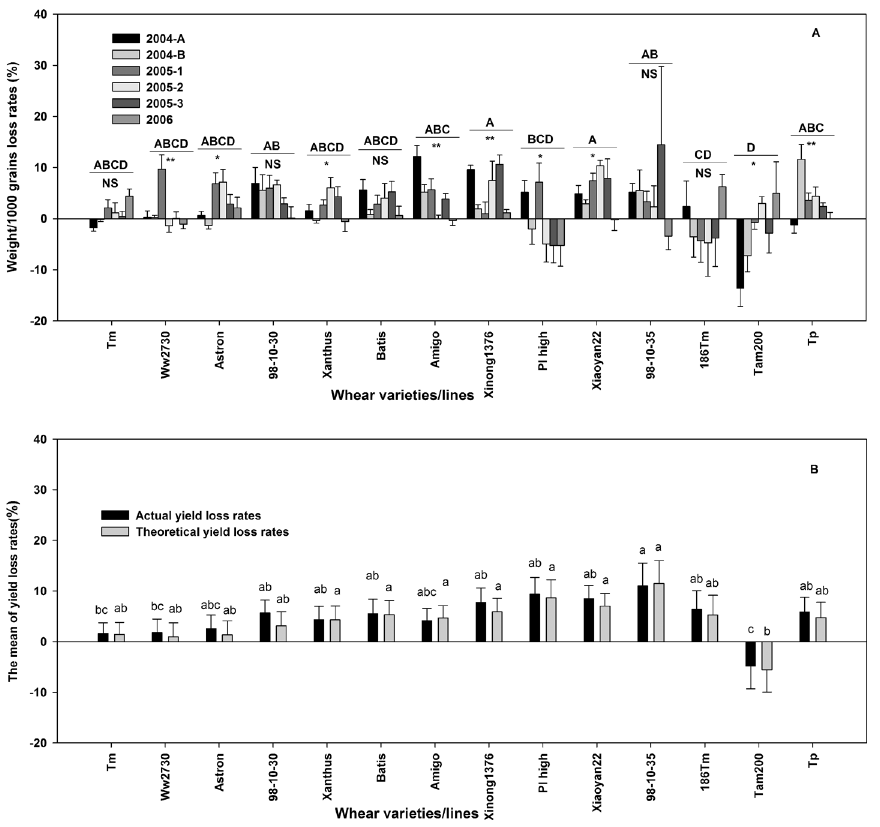
Fig 6. The loss rates of the 1000 grain weight (KW), for the 14 wheat varieties on 6 fields/sections over 3 years (A), and the loss rates average of theoretical yield (TY) and actual yield (AY) for the 14 wheat varieties based 6 fields/sections over 3 years. In part A, different capital letters above the horizontal lines indicate the significance of differences of the averages of the 6 fields/sections across the 14 wheat varieties/ lines. Strongly significant ( p < 0.01) values are marked as ‘ ** , ’ significant (0.05 < p < 0.01) differences are marked as ‘ * , ’ and non-significant ( p > 0.05) differences are marked as ‘ NS, ’ and are shown below the horizontal lines. In part B, different little letters above the bar indicate the significance of the differences for the averages of the varieties/lines (p <